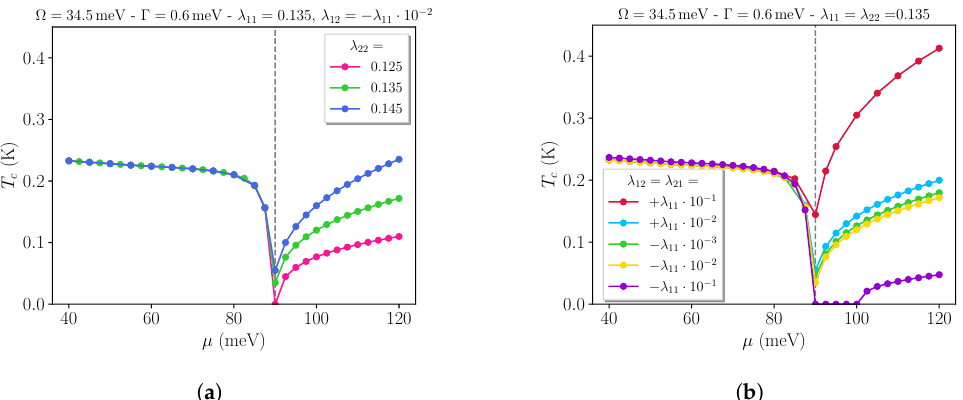
Figure 5. Calculations for the complete two-band disordered model presented in Section 2. The grey dashed line indicates the chemical potential corresponding to the Lifshitz transition, that is, ε 0 = 90meV. Here, we considered Γ = 0.6 meV, Ω = 34.5 meV and λ 11 = 0.135. ( a ) The inter-band λ 11 coupling constant are fixed as λ 12 = λ 21 = 10 − 2 , while varying λ 22 . ( b ) Here, λ 22 = λ 11 . − · while the values of λ 12 = λ 21 are